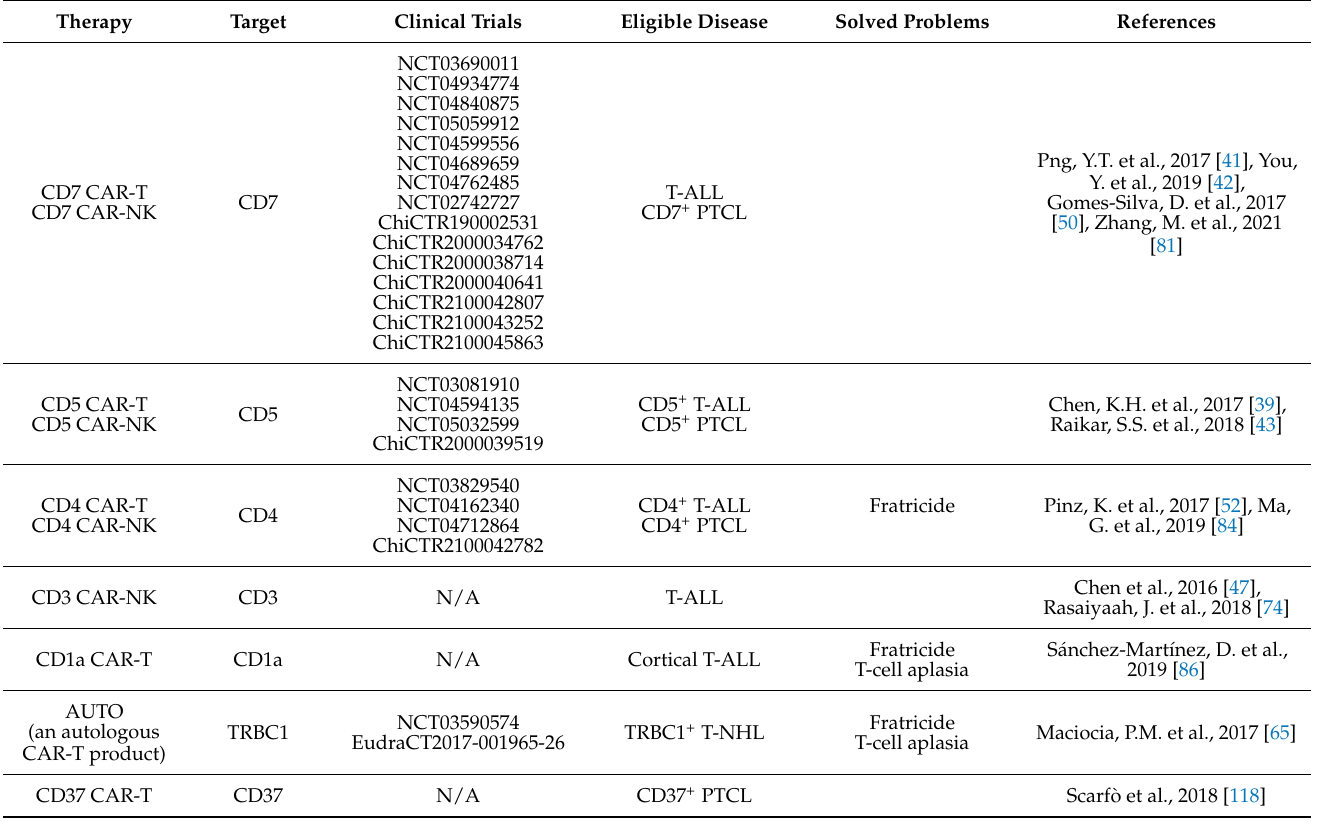
Table 1. Potential targets for immunotherapy of T-cell